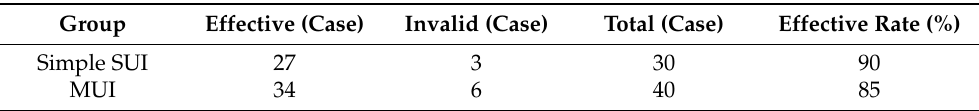
Table 2. Effective rate of postoperative SUI symptom treatment in simple SUI and MUI patients. (Case expressed in (%)).